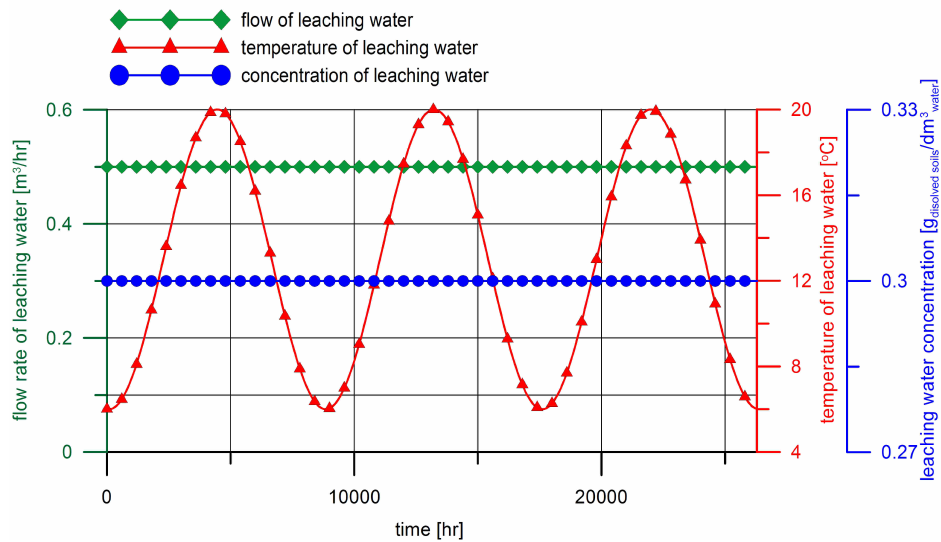
Figure 4. The parameters of leaching water in full model variant in which leaching begins in winter.